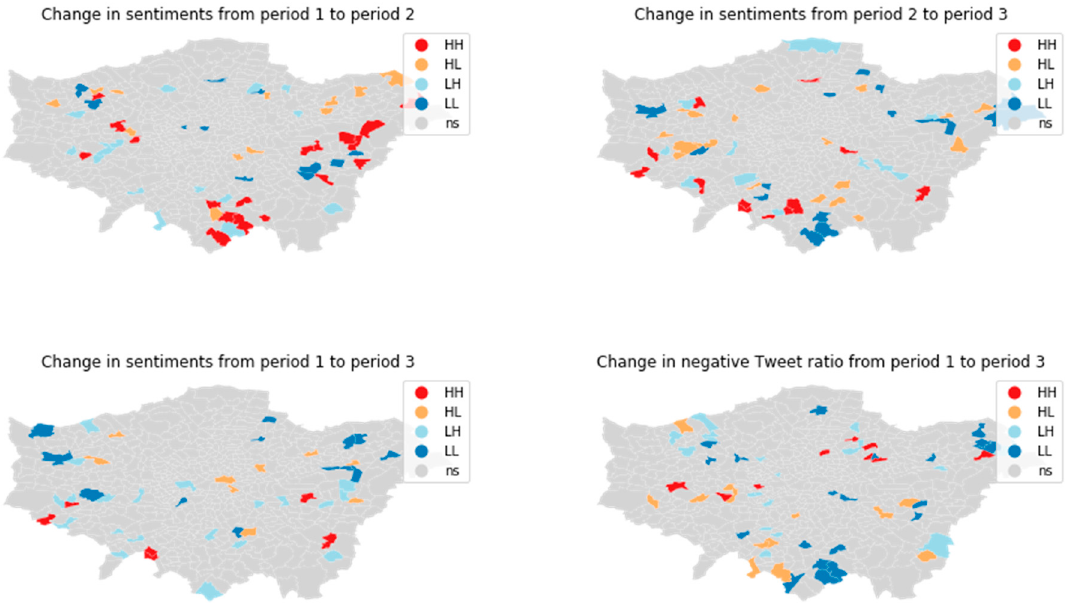
Figure 6. Comparison of spatial clusters (local Moran’s I, p < 0.05) of changes in sentiment scores over time for wards.